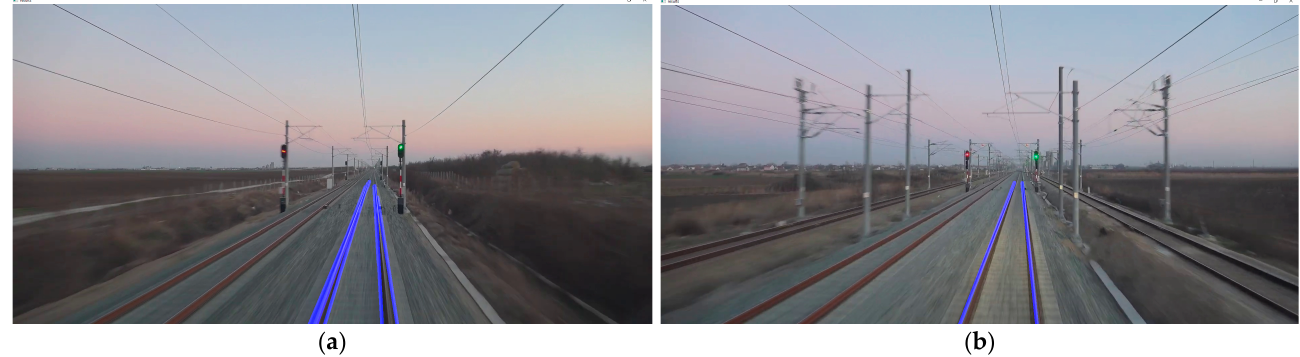
Figure 5. Hough transform, detected track of the train route marked by blue lines. ( a ) Two rail tracks; ( b ) three rail tracks.